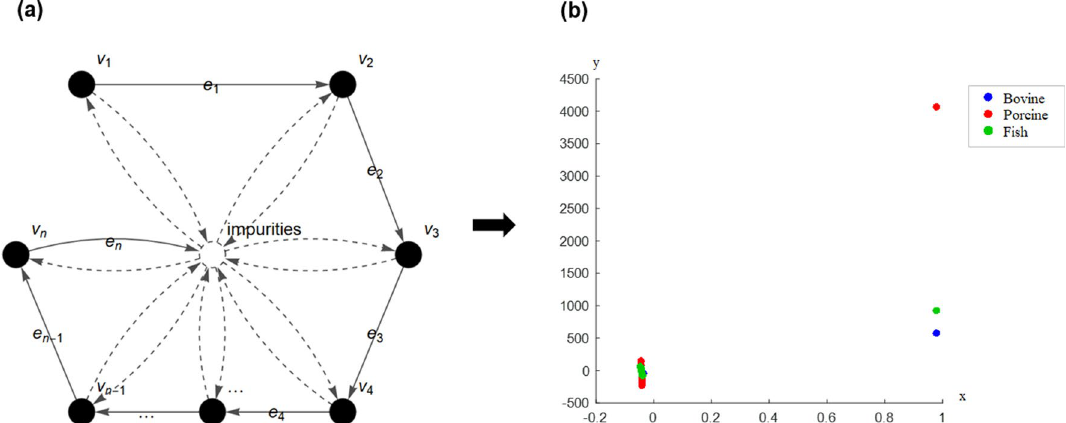
Figure 5. ( a ) FACS graph of FTIR gelatin spectra and ( b ) coordinated FACS of FTIR gelatin spectra.